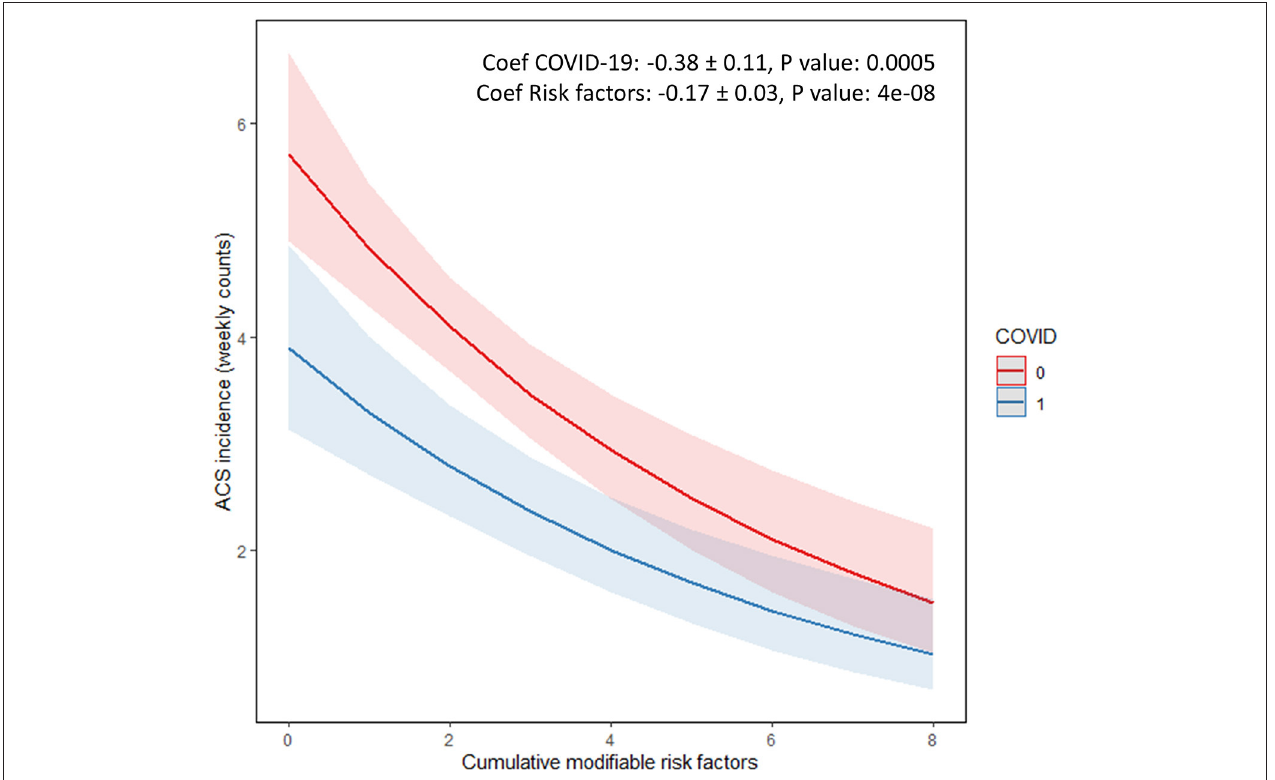
FIGURE 3 | Interaction plot of Poisson regression model showing an inverse association between the reduction of the incidence of Acute Coronary Syndrome during the Covid-19 lockdown period and the number of registered patient risk factors. Cumulative modifiable risk factors ( n ) included smoking, hypertension, diabetes, dyslipidemia, renal disease, peripheral arterial disease, atrial fibrillation, familial history, and previous history of coronary artery disease. The log coefficients for the Covid-19 disease and for each added individual risk factor are noted (R package sjPlot) (0, Non-covid-19 era 2019 and 2020; 1, Covid-19 era